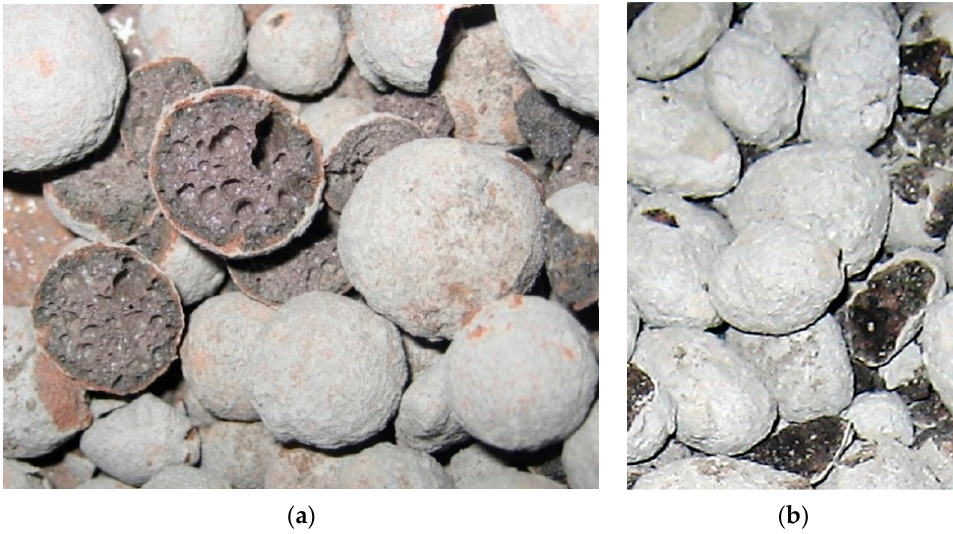
Figure 3. Expanded clay aggregates after crushing tests: ( a ) Liapor 8/16 mm, ( b ) Leca 8/16 mm.